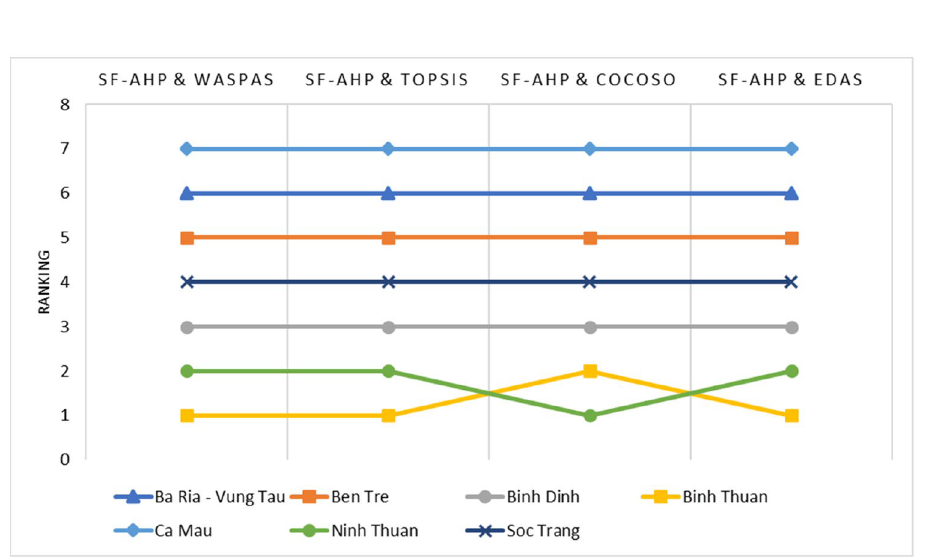
Figure 9. Ranking results of compared